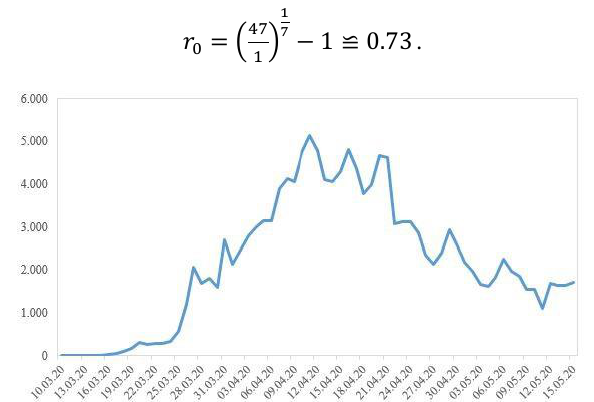
Fig. 1. Daily infected population number in Turkey.